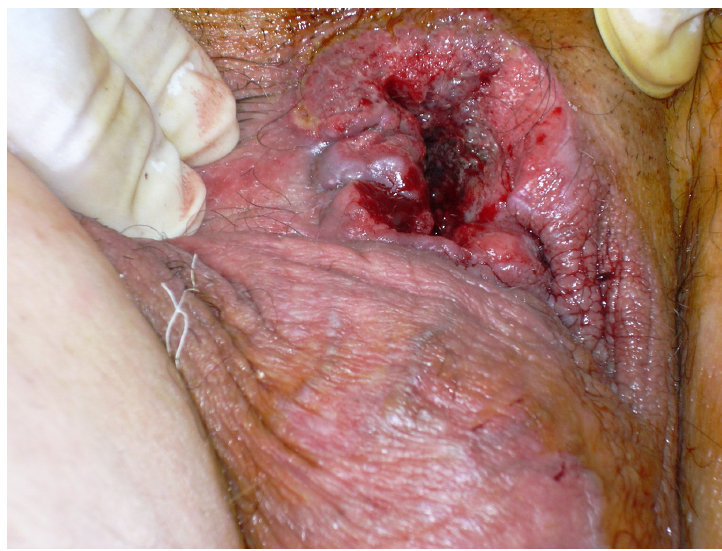
FIGURE 1. Ulcerative lesion in base of penis with urethral infiltration.